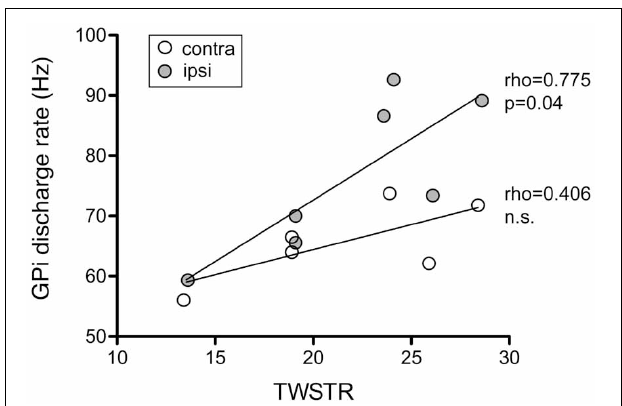
FIGURE 12 | Ipsilateral, but not contralateral, GPi firing rates of awake patients showed a significant positive correlation with torticollis symptom severity. Each data point represents collapsed averaged firing rates from the GPi contralateral (open circles) and ipsilateral to head turn (filled circles) for each patient. Torticollis severity was assessed using the severity subscale of the Toronto Western Spasmodic Torticollis Rating Scale (maximum score =